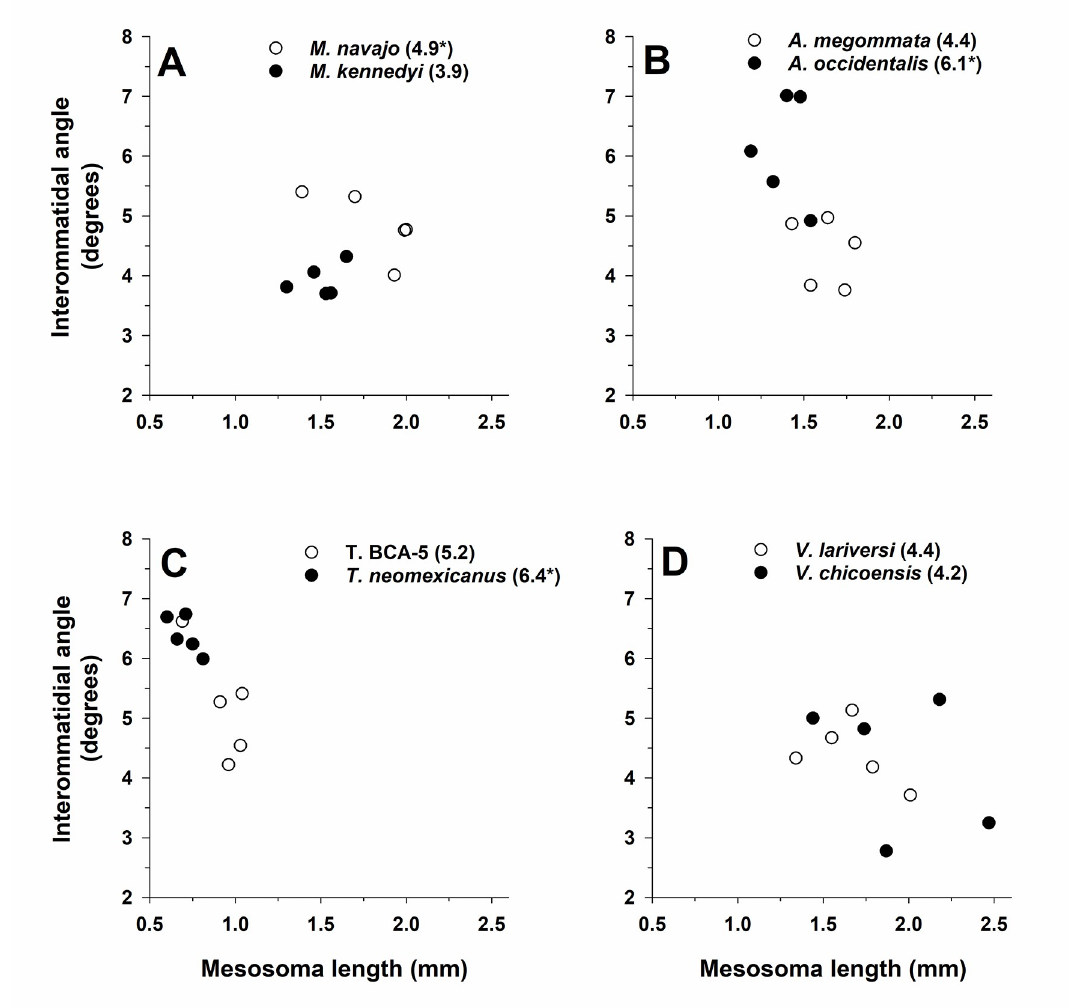
Fig 10. Interommatidial angle ( Δ ϕ ) for one pale (open circles and regular font) and one dark (filled circles and bold font) (see text) species in each of four ant genera: (A) Myrmecocystus , ( B ) Aphaenogaster , ( C ) Temnothorax , and ( D ) Veromessor . All plots have the same x-axis and y-axis scaling in order to visualize differences between light and dark species across genera. Mean Δ ϕ (in degrees) is given after each species name with an asterisk denoting the species with a significant larger Δ ϕ based on a t-test ( P < 0.05). The significant interaction of genus × activity period is shown by larger Δ ϕ’s for pale species of Myrmecocystus and Veromessor , whereas Δ ϕ was larger for dark species of Aphaenogaster and Temnothorax . Sample size is n = 5 for each species. and not varying with mesosoma length within species of Myrmecocystus and Aphaenogaster (Fig 10). Eye parameter ( ρ) . The ANCOVA for ρ was significant for genus (F = 11.6, 3,32 P < 0.001), activity period (F 1,32 = 11.2, P = 0.002), and the interaction of genus × activity period (F = 13.1, P < 0.001). As expected, overall ρ was higher for pale (mean = 1.70) than 3,32 for dark species (mean = 1.51), however, a significant genus × activity period interaction indi- cated differences in direction and magnitude of these differences (Fig 11). Pale species had the larger mean ρ in Myrmecocystus (t-test: t = -8.9, P < 0.001), while values did not differ 8 df between pale and dark species in the other three genera ( Veromessor : t = -0.3, P = 0.74; Tem- 8 nothorax : t 4 = -1.7, P = 0.16; Aphaenogaster : t 8 = -2.2, P = 0.058). Across genera ρ was highest